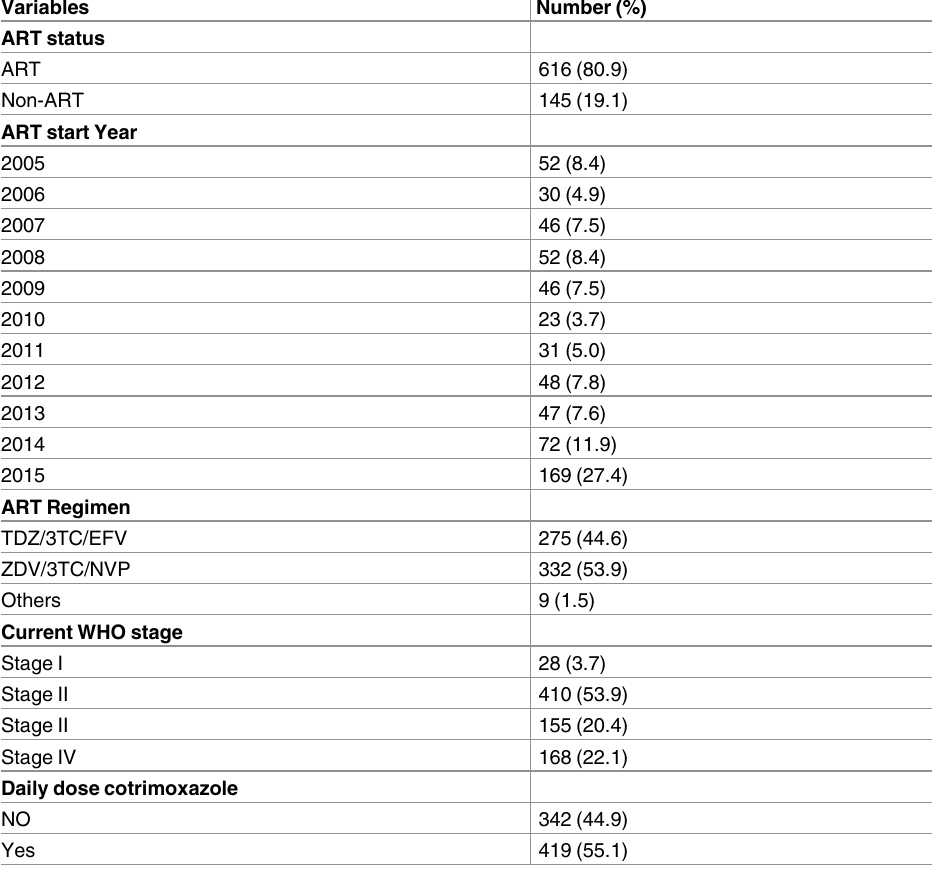
Table 2. Clinical Information of HIV Patients Attending ART Clinic at Infectious Disease Hospital (n =